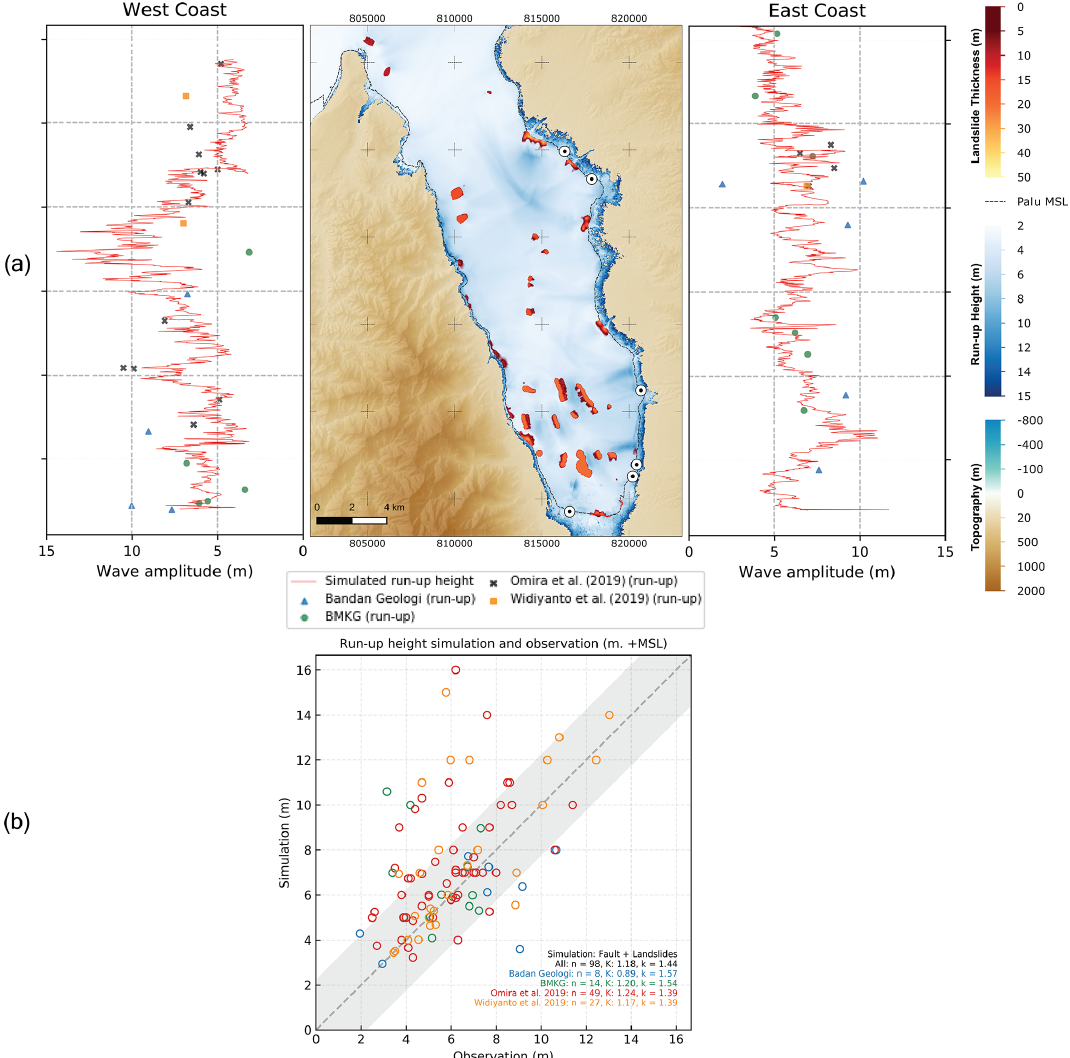
Figure 7. Simulated tsunami run-up heights resulting from the modeled submarine landslides based on Hovland’s slope stability analysis and combined with past studies’ observed submarine landslides. All the submarine landslides presented in the figure were used to model the tsunami run-up height. (a) Calculated maximum tsunami amplitude (center) with the maximum calculated tsunami amplitude (red line) at the shoreline of the western coast (left) and the eastern coast (right), as well as the measured run-up heights from Badan Geologi’s report (blue triangles), BMKG (green circles), Omira et al. (2019) (crosses), and Widiyanto et al. (2019) (yellow squares). (b) Comparison between simulated and observed tsunami run-up heights by Badan Geologi’s report (blue), BMKG (green), Omira et al. (2019) (red), and Widiyanto et al. (2019) (yellow), as well as the comparison index, K , and κ values. n stands for the total number of observations. The gray shading represents the error related to the over-/underestimation, i.e., ± standard deviation ( ∼